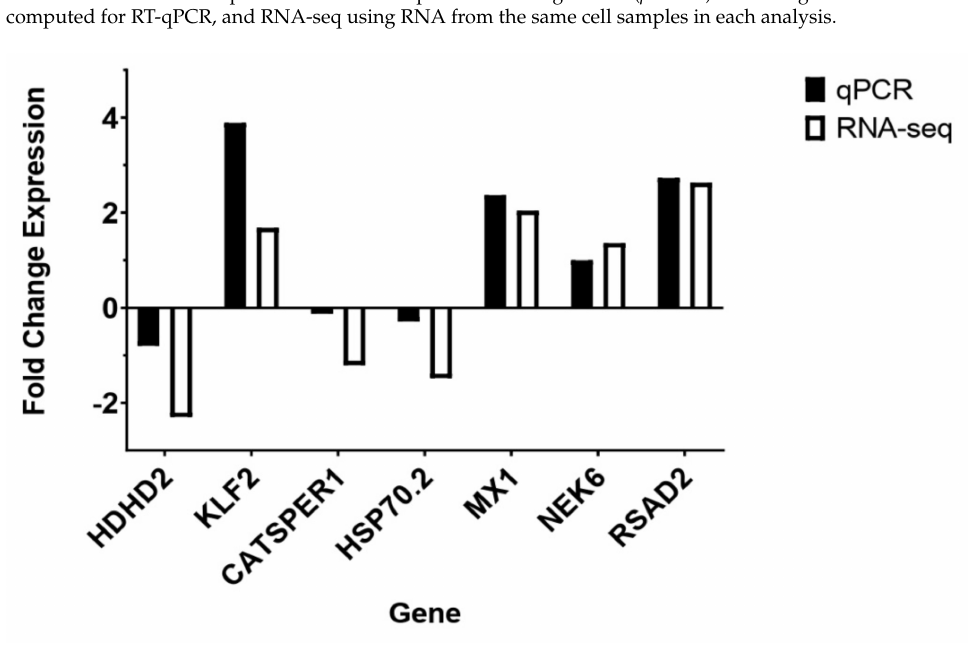
Figure 3. Validation of DEGs from RNA-seq in HIEC and IPEC